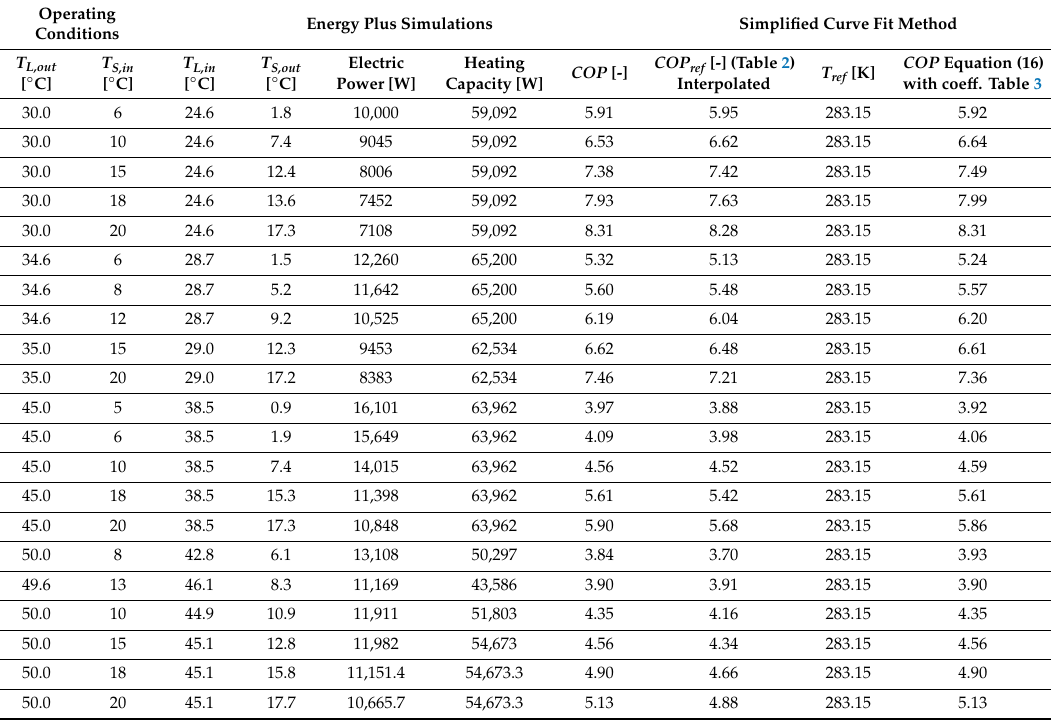
Table A2. Benchmark simulations for the water-to-water heat pump (heating case).